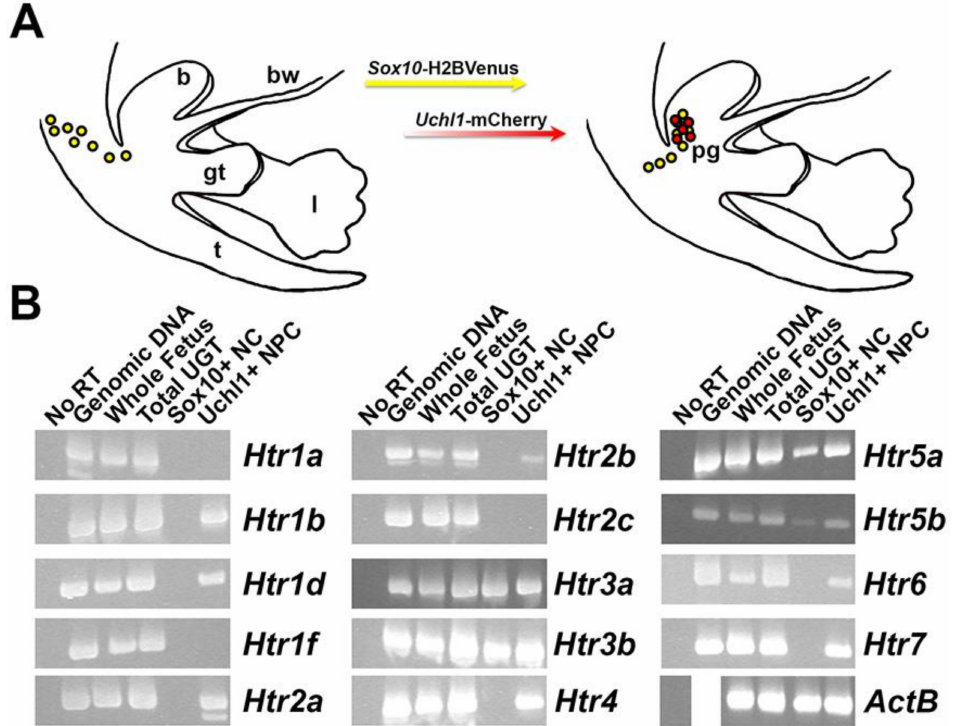
Figure 3. Expression of serotonin receptor genes in sacral neural crest-derived progenitors and pelvic ganglia neuronal precursors. RT-PCR conducted on cDNA derived from distinct cell populations in the lower urinary tract at 15.5 dpc reveals the expression of a subset of serotonin receptors in developing pelvic innervation. ( A ) Schematic diagram shows the distribution of cells marked by two transgenic mouse lines that were used to isolate distinct cell populations within the developing lower urinary tract. NCPs expressing Sox10 -H2BVenus transgene (yellow) migrate into the LUT and upon neuronal differentiation up-regulate the Uchl1 -mCherry transgene (red). cDNA was synthesized from isolated RNA that was purified from these two cell populations by FACS. ( B ) Gel electrophoresis of RT-PCR products generated by the specific amplification of 5-HT receptor genes. cDNA was synthesized from whole mouse fetus, total lower urinary tract (bladder with attached genital tubercle), Sox10 -H2BVenus+ cells isolated by FACS, and pelvic Uchl1 -mCherry+ neuronal progenitor RNA. Template with no reverse transcriptase added to the cDNA synthesis reaction (“No RT”) served as a negative control; genomic DNA template served as a positive control. Amplification of housekeeping gene ActB served as a positive control for the PCR reaction. (b, bladder; t, tail; gt, genital tubercle; l, limb bud; bw, body wall; pg, pelvic